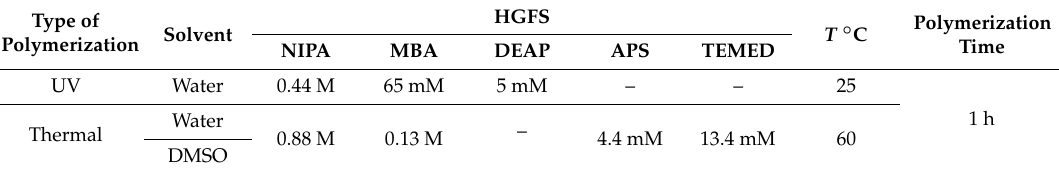
Table 3. Bulk fluorescent hydrogels: composition of hydrogel forming solutions and conditions of